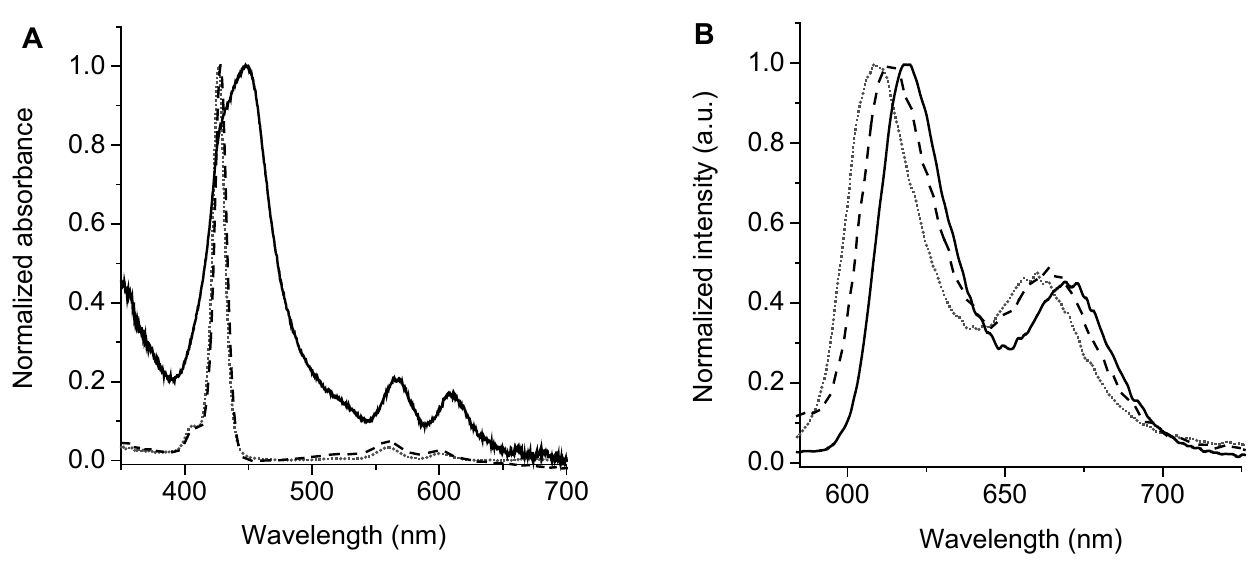
Figure 2. ( A ) UV-visible absorption and ( B ) fluorescence emission spectra of PZnTEP (solid line), ZnTEP (dashed line), and ZnTMP (dotted line) in DMF ( λ exc = 565 nm). Table 1. Spectroscopic and photodynamic properties of ZnTMP, ZnTEP, and PZnTEP in DMF.